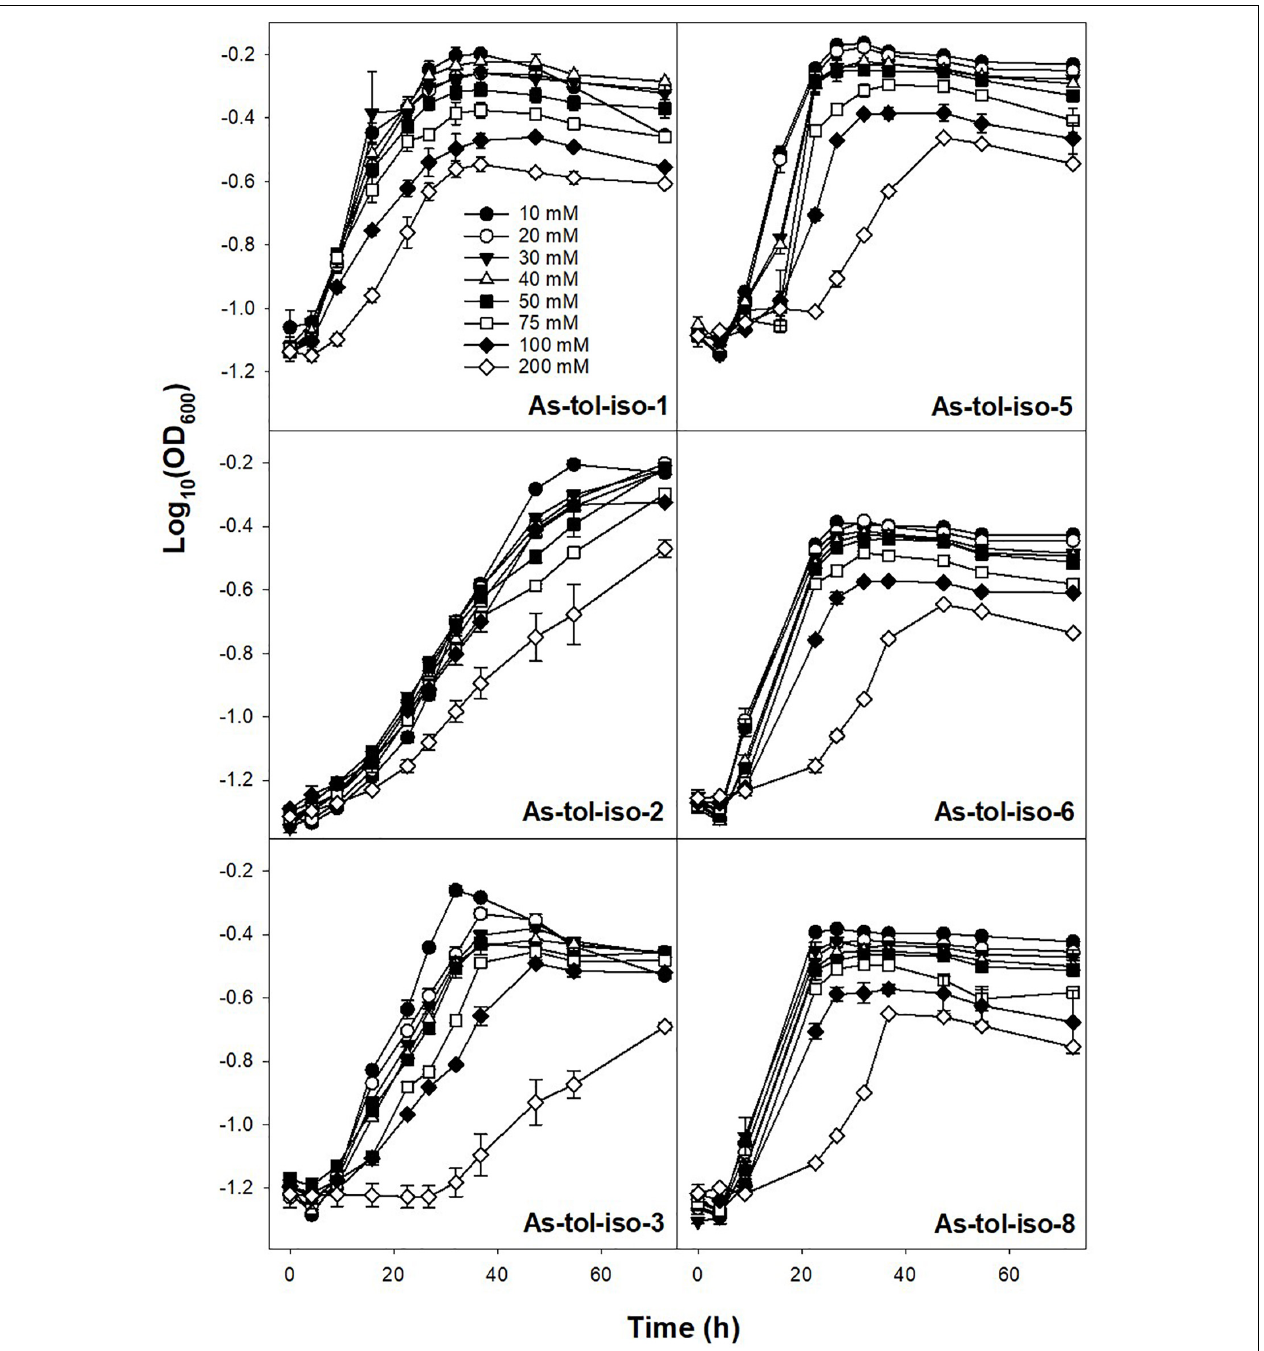
FIGURE 5 | Effect of arsenate concentration on the growth of isolated arsenic-tolerant peat microorganisms. Strains were incubated in medium for arsenic-tolerant microorganisms supplemented with 10–200 mM arsenate and 10 mM arsenite at 20 ◦ in the dark. Mean values and standard errors of three replicates are shown.